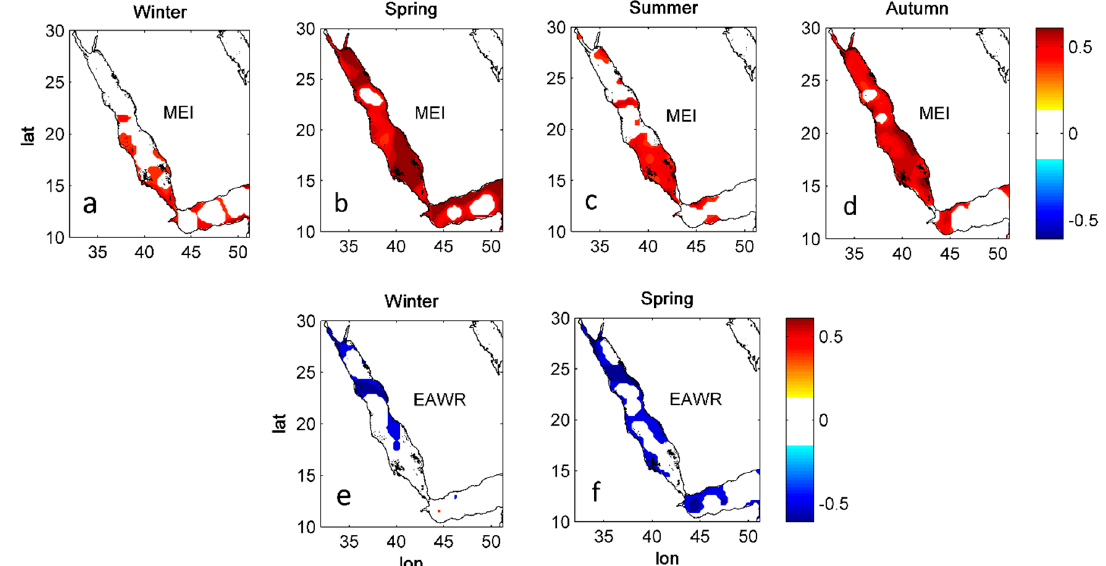
Figure 5. The spatial correlation pattern of raw SLA data with El Niño Southern Oscillation (ENSO) during all seasons ( a – d ) and East Atlantic / West Russia (EAWR) during winter and spring seasons ( e , f ). Only 95% significance level results are plotted.